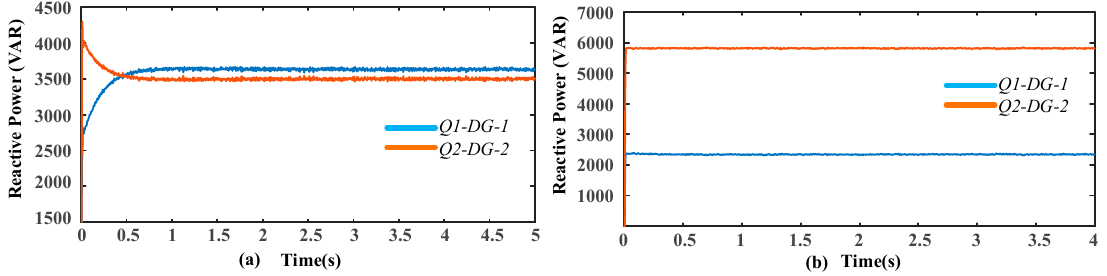
Figure 10. ( a ) Active power for the conventional control strategy; ( b ) active power for proposed control strategy.